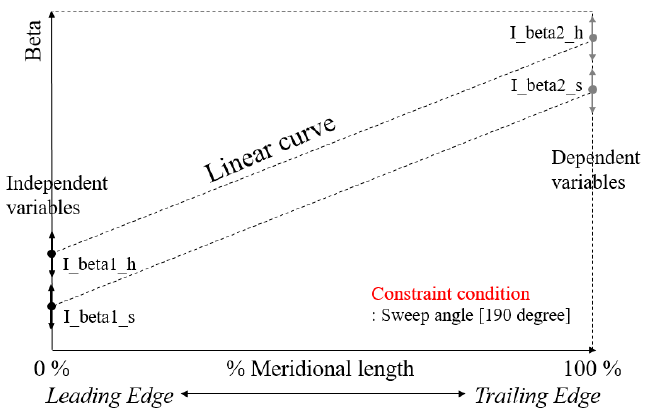
Figure 4. Definition of design variables of the impeller.